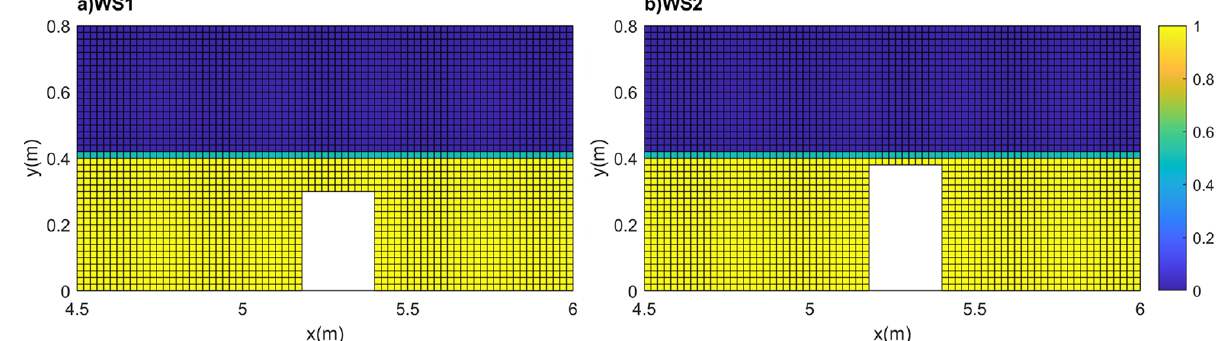
Figure 2. Grid meshing for WS1 ( a ) and WS2 ( b ).